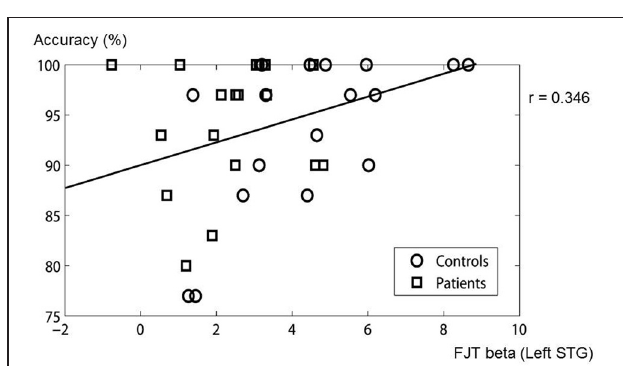
light blue area represents greater activation in patients than in controls; pink area represents less activation in patients than in controls. MFG, middle frontal gyrus; IFG, inferior frontal gyrus; aSTG, anterior superior temporal gyrus; SPL, superior parietal lobe; TPJ, temporo-parietal junction; IPL, inferior parietal lobe.